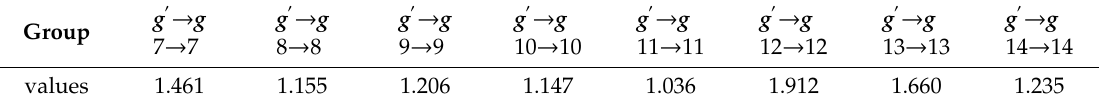
(cid:16) N 1,1 , σ g